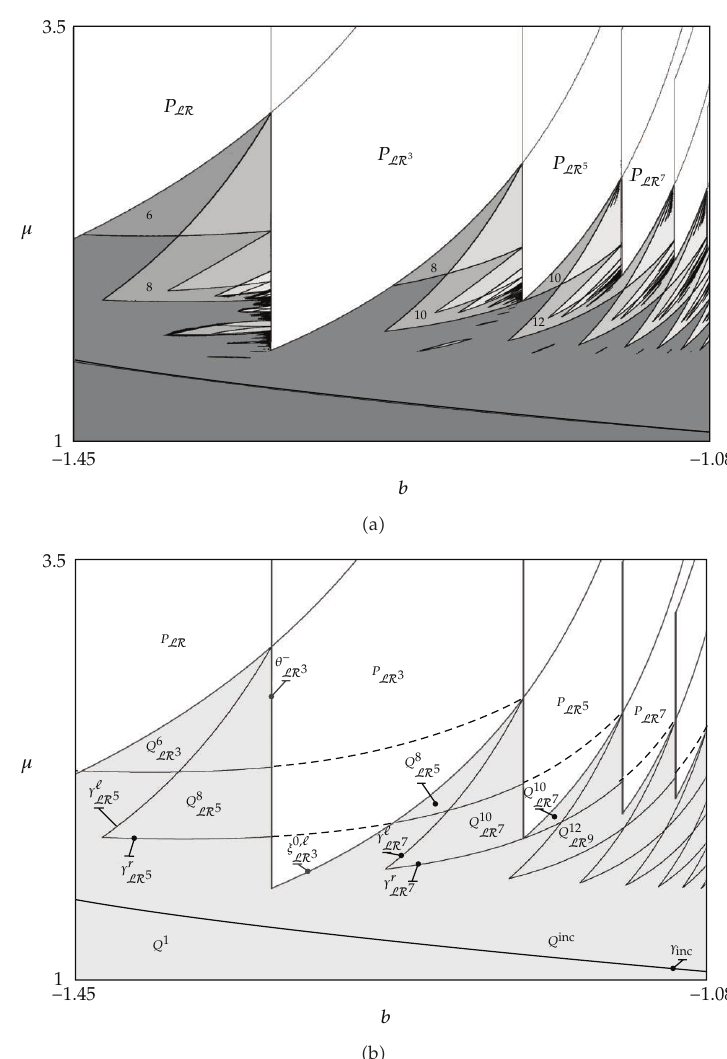
Figure 13: Parameter space diagram for a (cid:6) 0 . 42, b (cid:6) − 1 . 45 ··· − 1 . 08, μ (cid:6) 1 . 0 ··· 3 . 5. (cid:7) a (cid:8) shows the numerically determined bandcounts, while (cid:7) b (cid:8) shows the corresponding analytically determined diagram. In (cid:7) a (cid:8) , regions are labeled with their bandcounts. The borders of two regions Q 8 LR consisting of the band-merging crises γ (cid:2) LR Dotted lines show band-merging crisis curves inside periodic